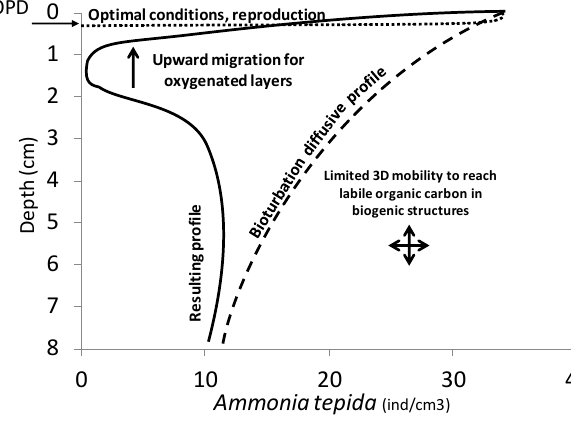
Figure 8. Putative mechanisms explaining the A. tepida density pro- file (OPD: oxygen penetration